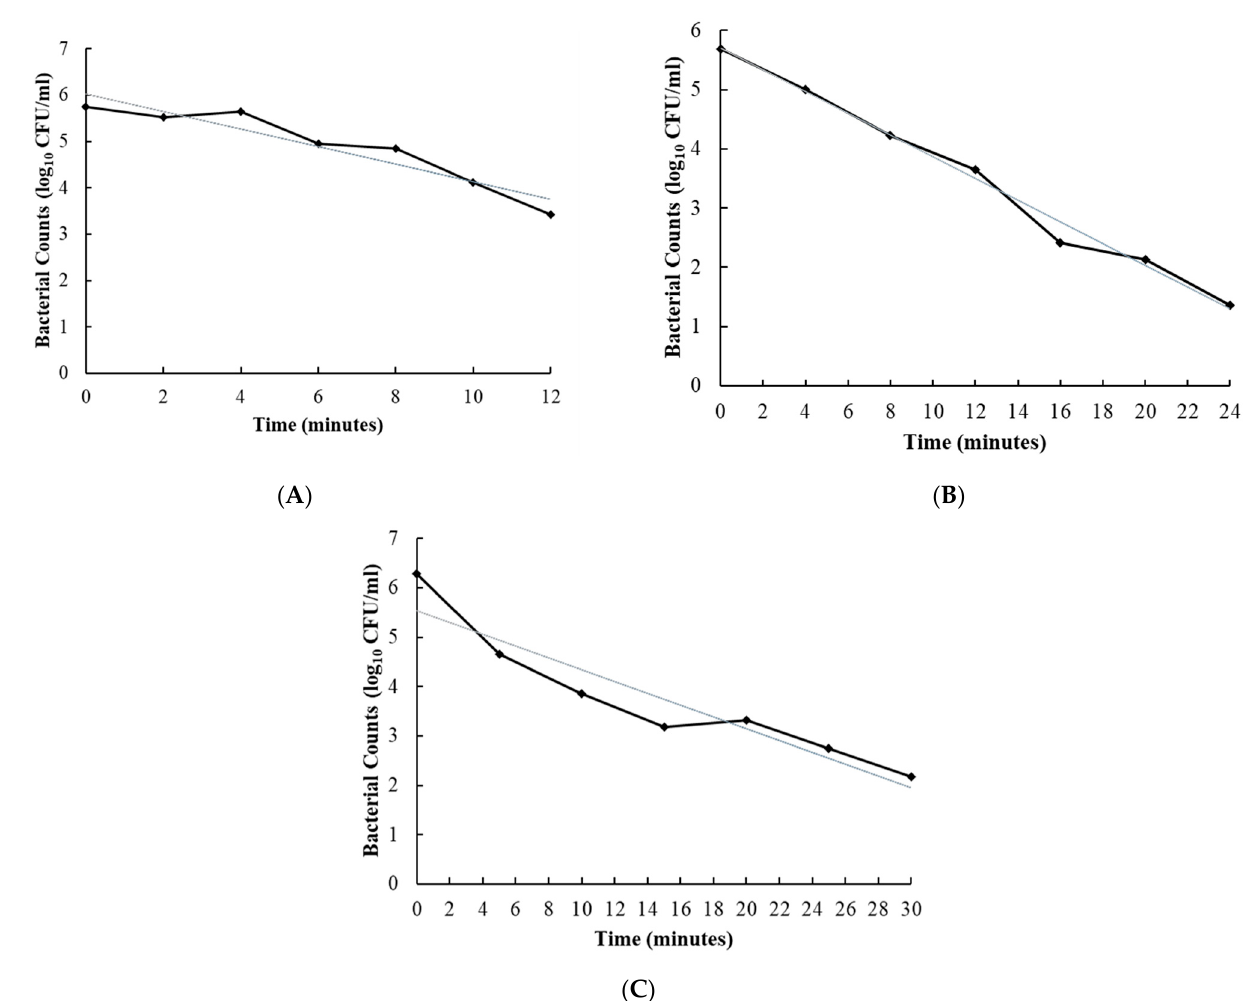
Figure 2. Inactivation of Clostridioides difficile by disinfecting agents (disinfectants 2 ( A ), 7 ( B ) and 10 ( C )). Solid line represents the observed values over different time points. The straight line represents the linear regression to determine the slope and to calculate D values. Table 3. Calculated D values for Clostridium sporogenes and Clostridioides difficile spores treated with most effective disinfectants (2, 7 and 10).